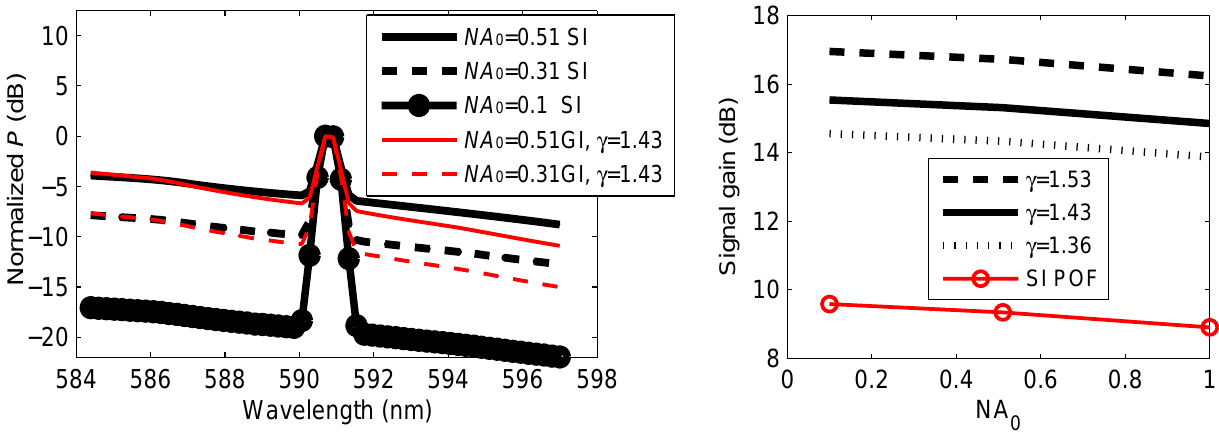
Figure 10. ( a ) Normalized spectral power distributions for several values of the numerical aperture, for SI and GI POFs. ( b ) Signal gain as a function of NA Parameters as in Table